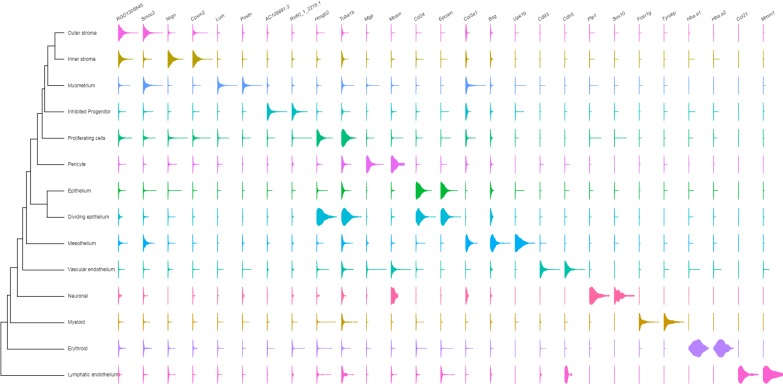
Single-cell RNA-seq reveals the cell atlas of the developing PND 6 uterus.Violin plots of the top two marker genes revealed by highest p values (Figure 3—source data 1 and Table 1).